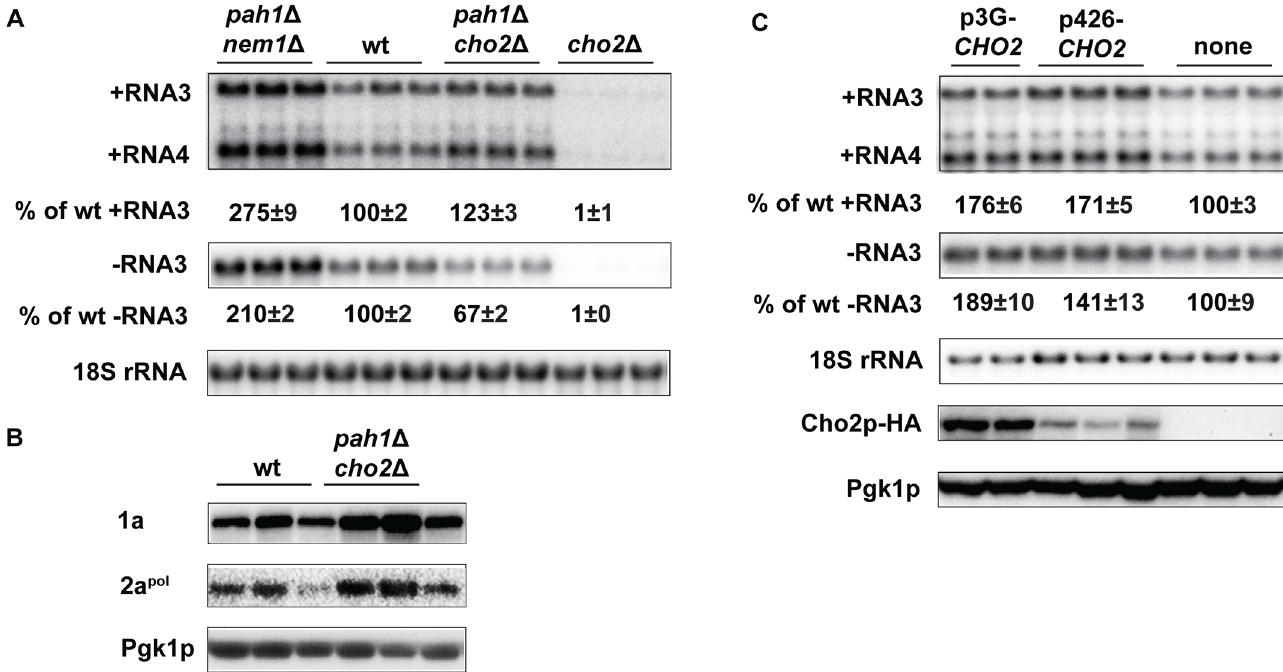
Fig 8. The active synthesis of phosphotidylcholine is required for the enhanced BMV replication in pah1 Δ cells. (A) BMV replication in wt, cho2 Δ , pah1 Δ cho2 Δ and pah1 Δ nem1 Δ cells. (B) BMV 1a and 2a pol accumulation in wt and pah1 Δ cho2 Δ cells. Protein extraction and Western blotting were done as in Fig 2F. (C) Over-expression of CHO2 promotes BMV replication in wt cells. Low or high levels of Cho2p-HA was expressed from p426- CHO2 (a high-copy-number plasmid) or p3G- CHO2 (a low-copy-number plasmid) under the control of the CHO2 or GAL1 promoter, respectively. The bottom panel shows accumulated Cho2p that was expressed from different vectors. Pgk1p serves as a loading control.